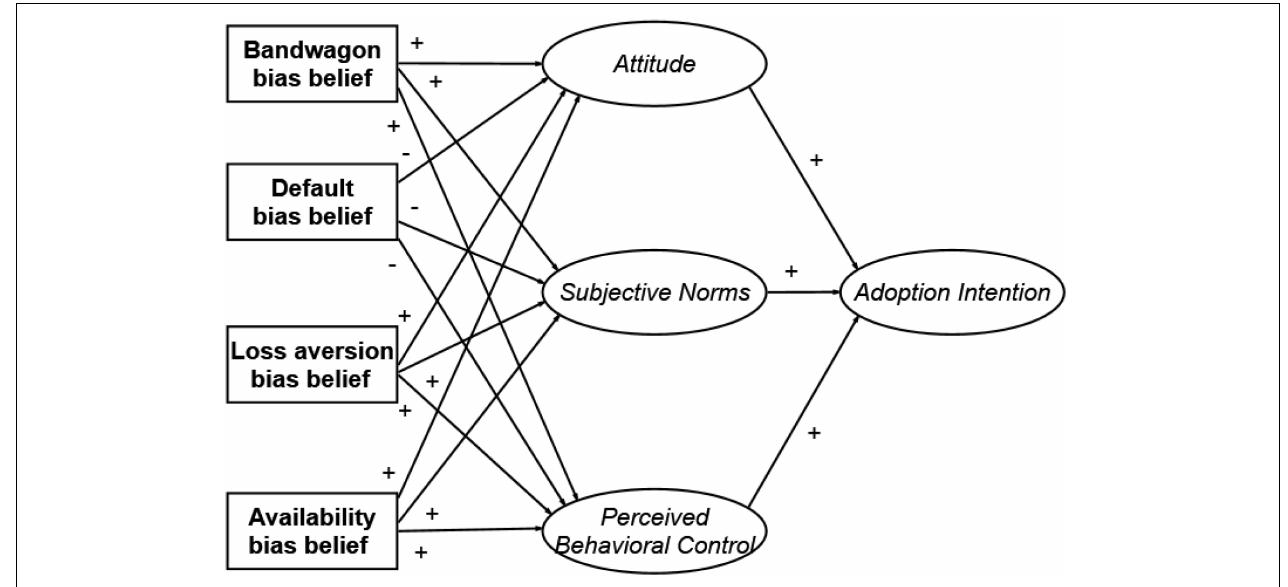
FIGURE 1 | A conceptual model. The determinants of the TPB are indicated in font italic; the biased beliefs are indicated in font bold.